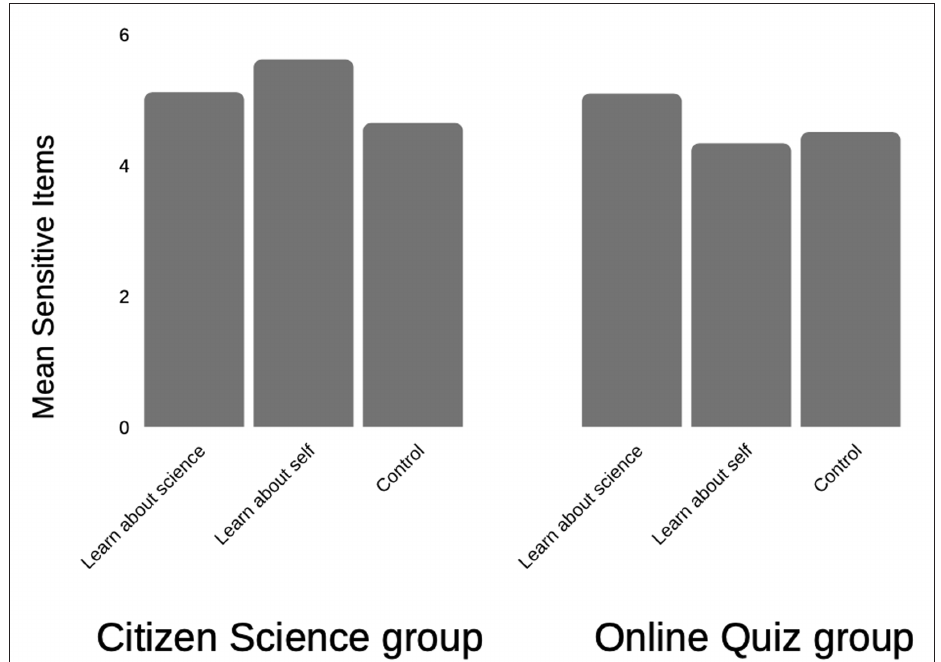
Figure 1 Mean disclosure of sensitive data across the three Message groups in the Citizen Science group and Online Quiz